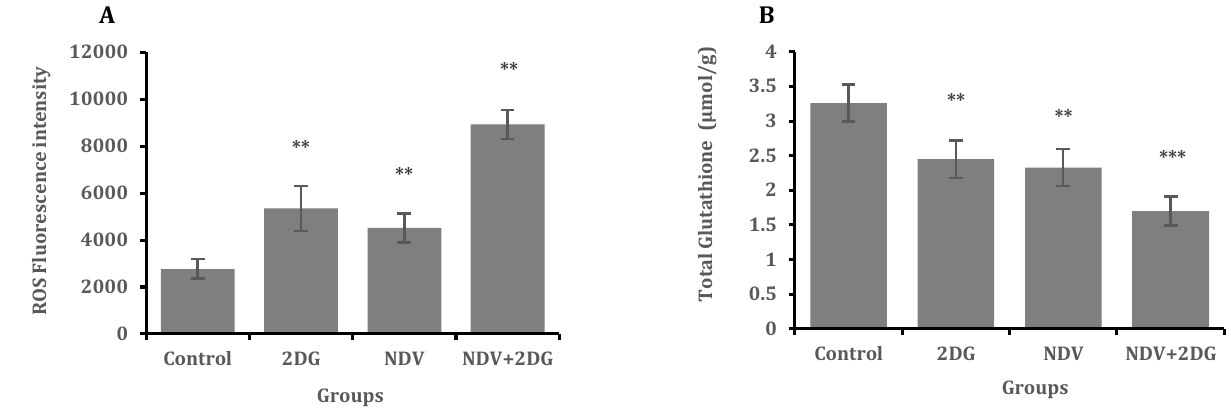
Figure 3 . Effect of 2DG and NDV on metabolic oxidative stress on breast cancer in female mice. A) , ROS Levels. B) , Total glutathione